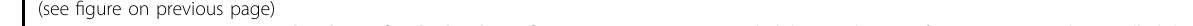
Fig. 7D. We conducted a ChIP assay and identi fi ed that the SP1 promoter was remarkably pulled down by anti-SOX2